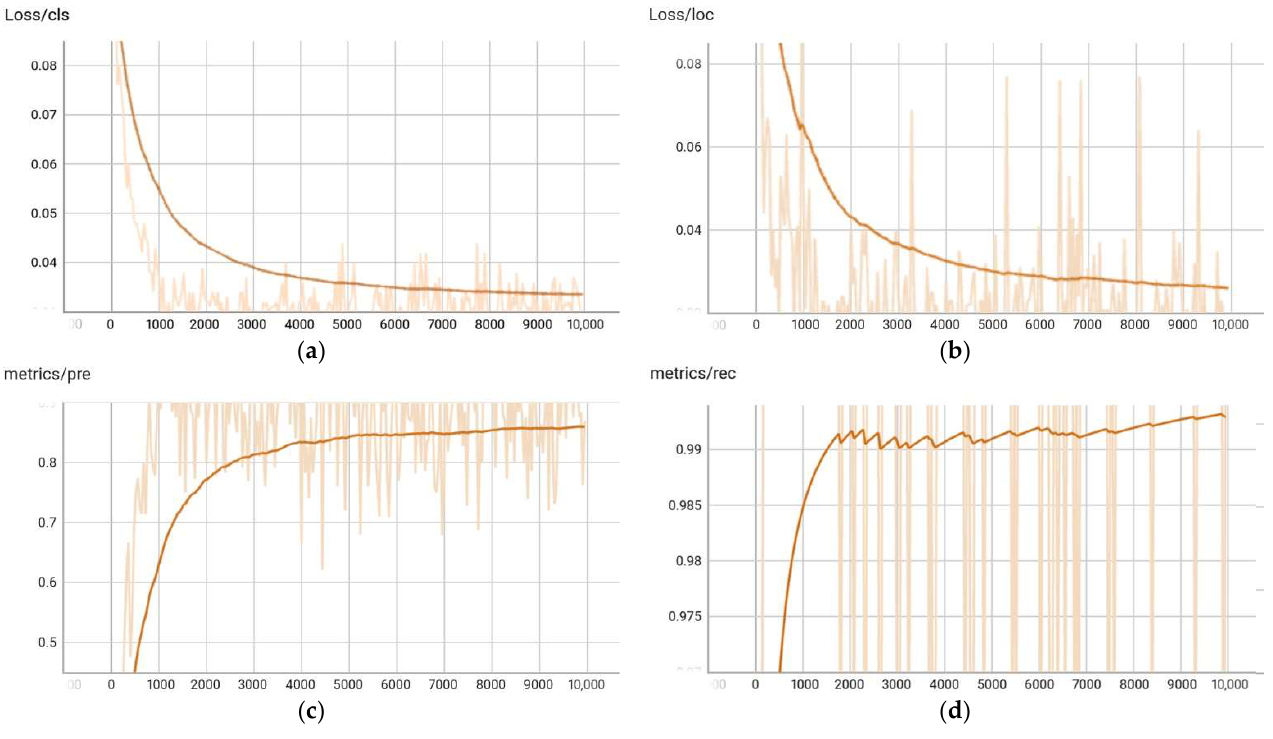
Figure 8. Metrics graph obtained from the GCN learning on the Chess in the 7-Scenes Dataset.; x-label (# of iteration), y-label (( a ) class loss; ( b ) location loss; ( c ) precision; ( d ) recall.)